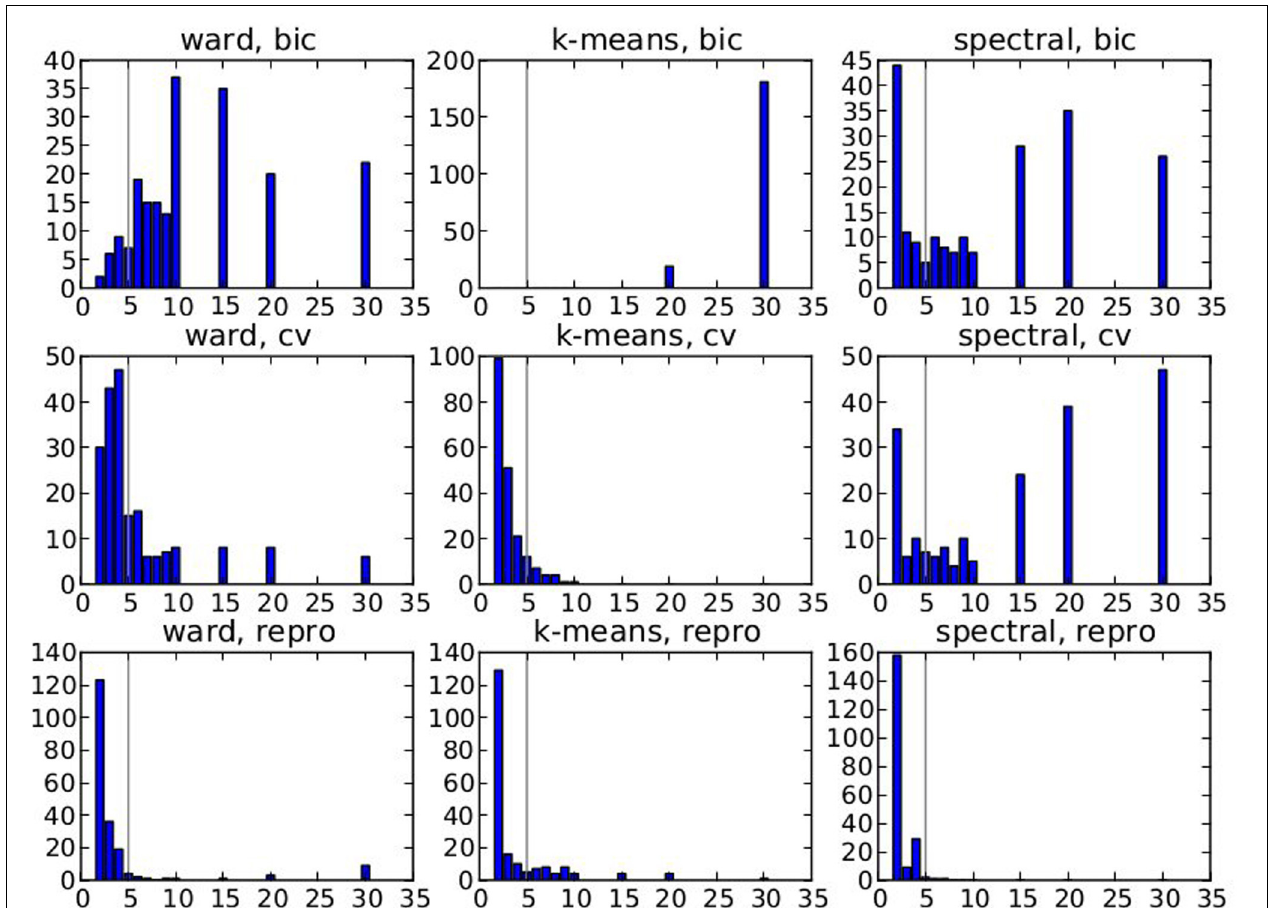
FIGURE 2 | Results of the simulations: choice of the number parcels for different clustering methods and cluster selection techniques. Note that the range of possible values is [2, 3, 4, 5, 6, 7, 8, 9, 10, 15, 20, 30] and that the true value is 5. The results are based on data smoothed with a kernel of